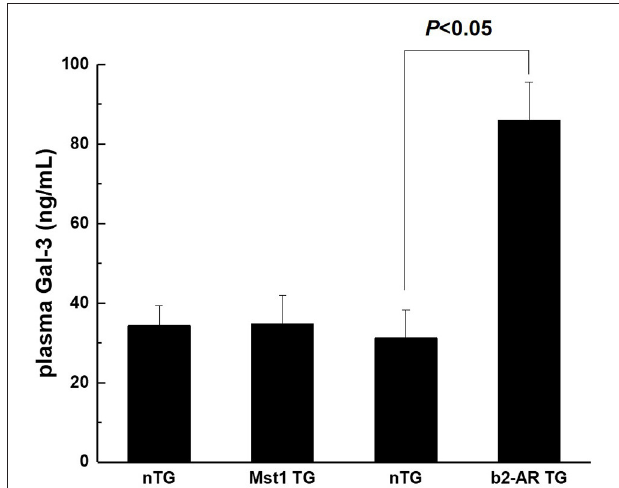
FIGURE 1 | Plasma concentration of Gal-3 from nTG, Mst1-TG, and β 2-AR-TG hearts in mice. Gal-3, galectin-3; nTG: non-transgenic mice; b2-AR